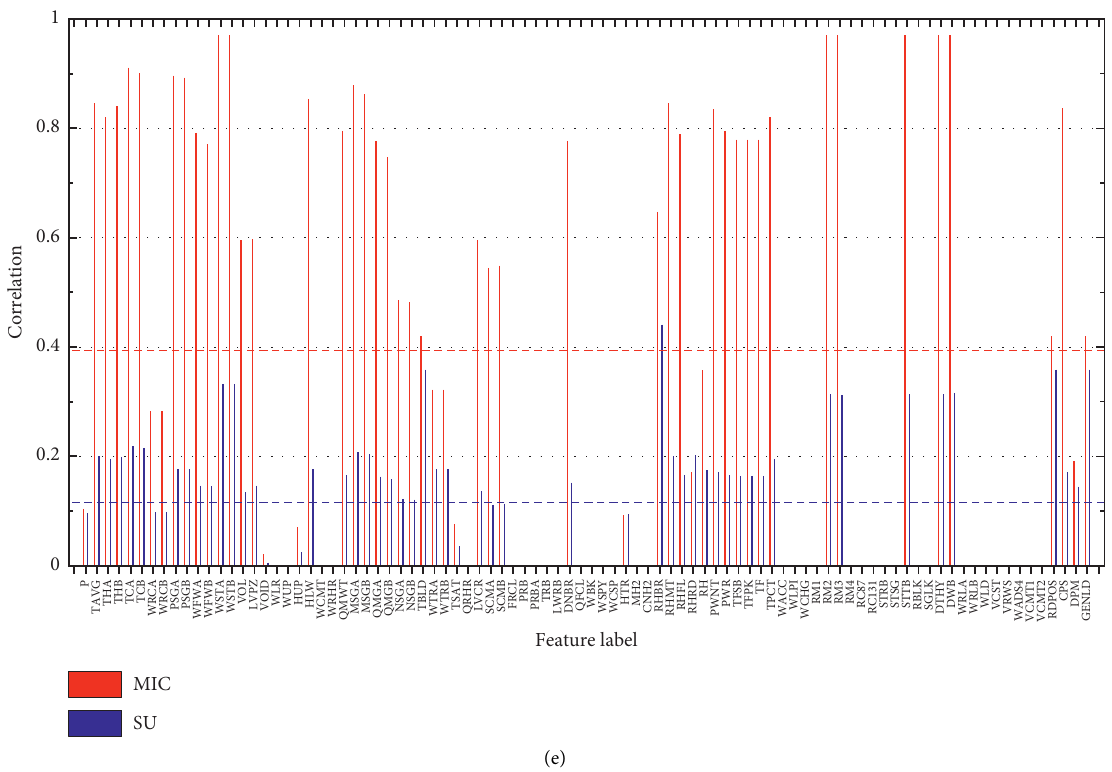
Figure 4: Results of correlation measure verification experiment. (a)–(e) represent experiments 1 to 5, and the dotted line represents the average value.